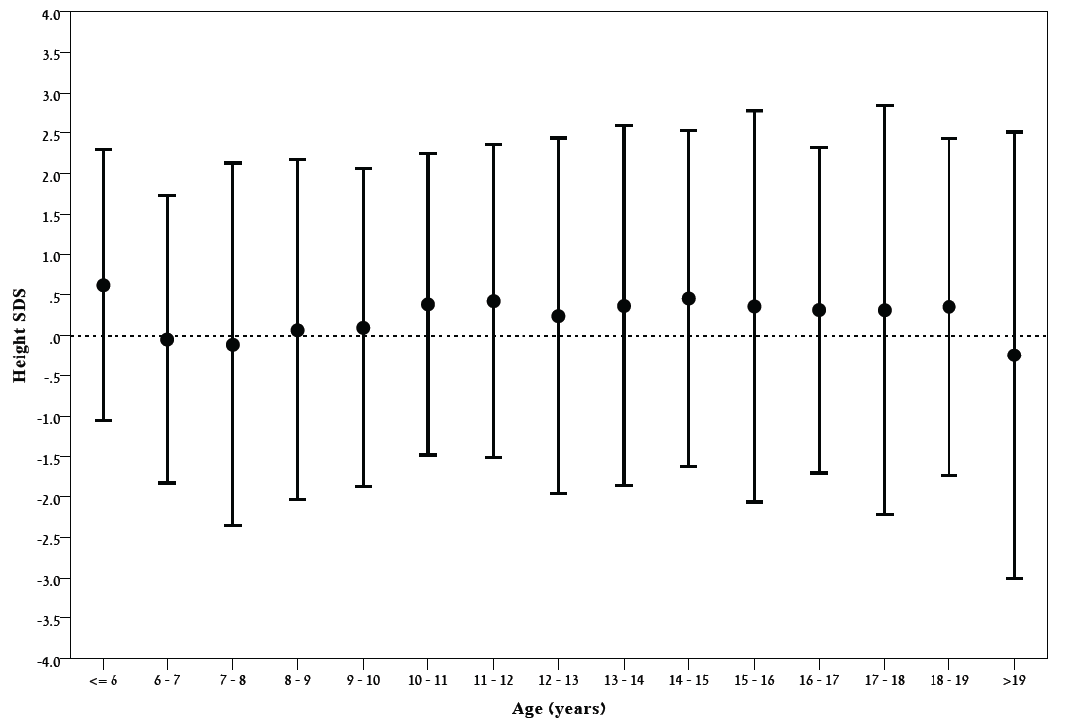
Figure 1. Height SDS presented as the mean +95% confidence interval across age groups for all study participants ( n = 2276).